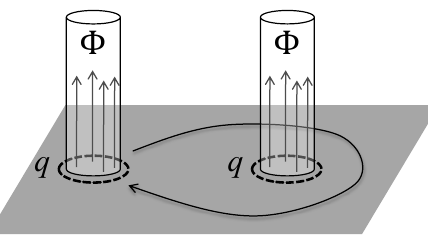
Figure 2: Toy model for anyons as charge-flux composites where magnetic flux Φ confined to a tube that is encircled by a ring of electric charge q . When one such composite object moves around the other, its charge (flux) circulates the flux (charge) of the other anyon. The Aharonov-Bohm effect gives rise to the complex phase e 2 iq Φ , which describes the mutual statis- tics of the composite objects. If 2 q Φ is not an integer multiple of 2 π , the composite objects are Abelian